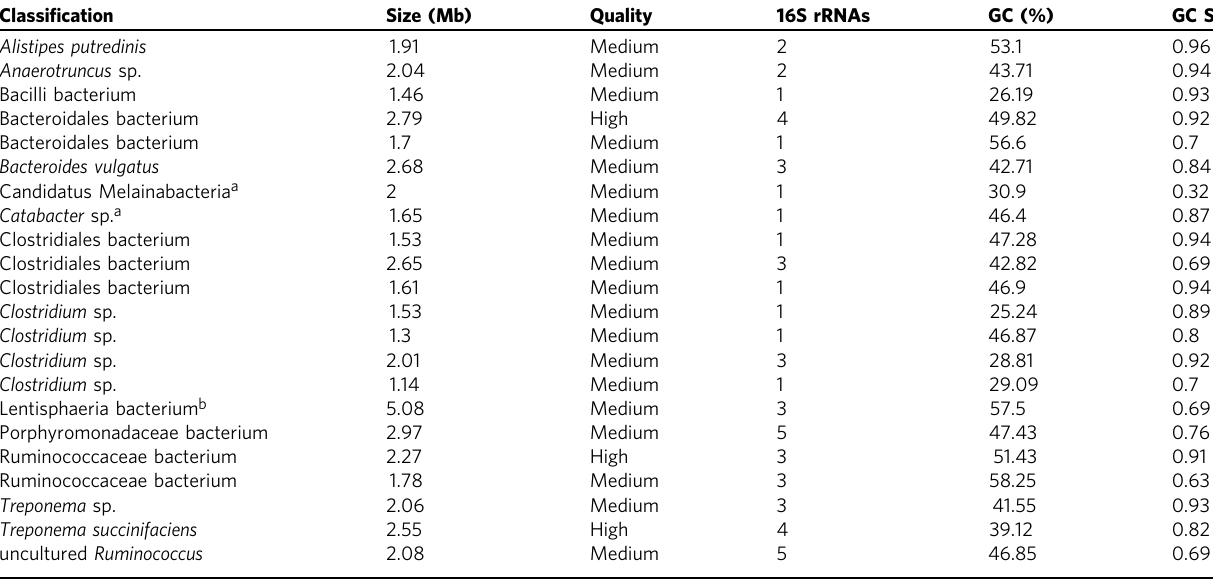
Table 2 Nonredundant single-contig genomes assembled from nanopore sequencing. Classi fi